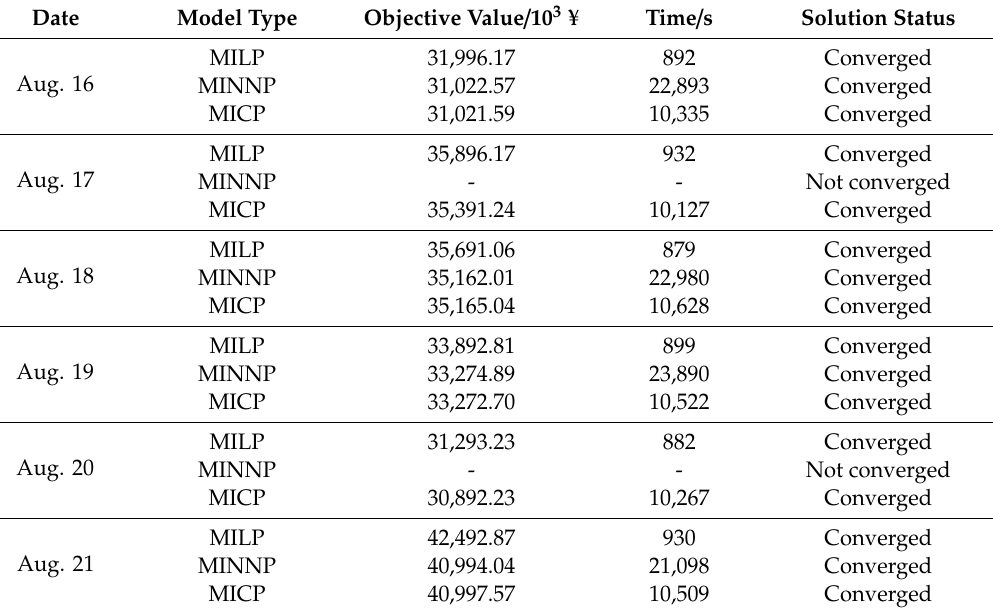
Table 13. Results from several days’ data by three SCUC